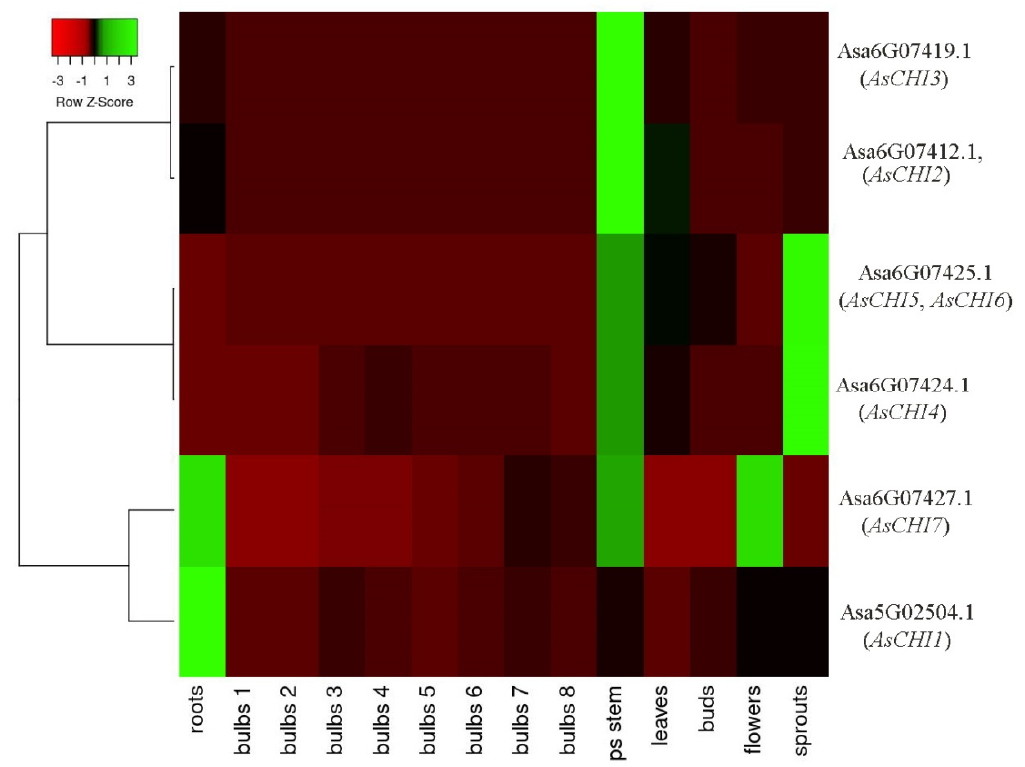
Figure 3. Heatmap of AsCHI1–7 mRNA expression in Allium sativum cv. Ershuizao tissues. Gene transcription was analyzed in roots, bulbs (1, 2, 3, 4, 5, 6, and 7 correspond to 192-, 197-, 202-, 207-, 212-, 217-, 222-, and 227-day-old bulbs), pseudo (ps) stems, leaves, buds, flowers, and sprouts. Colors red to green indicate a gene expression gradient from low to high.